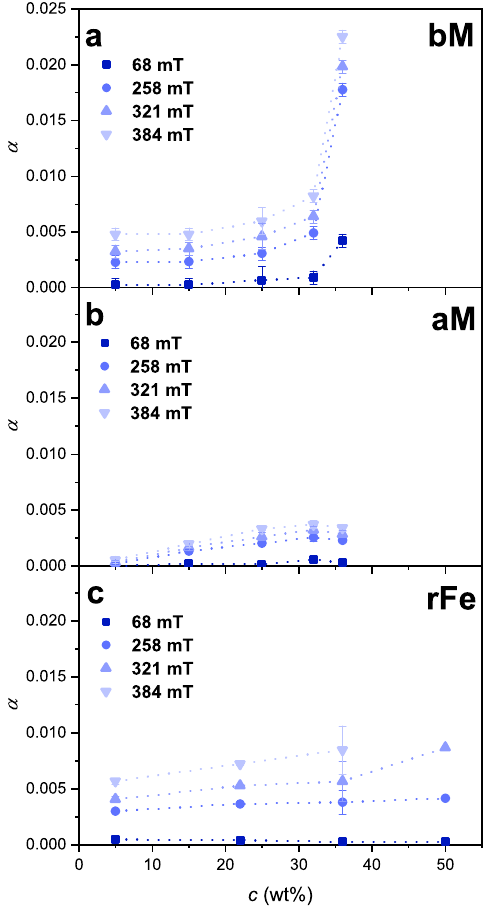
Figure 8. The dependence of the dilation on the particle loading in case of different filler materials (bM magnetite ( a ), aM magnetite ( b ), and rFe iron ( c )) at various magnetic flux densities. The dotted lines are a guide for the eye. In some cases, the error bar is smaller than the